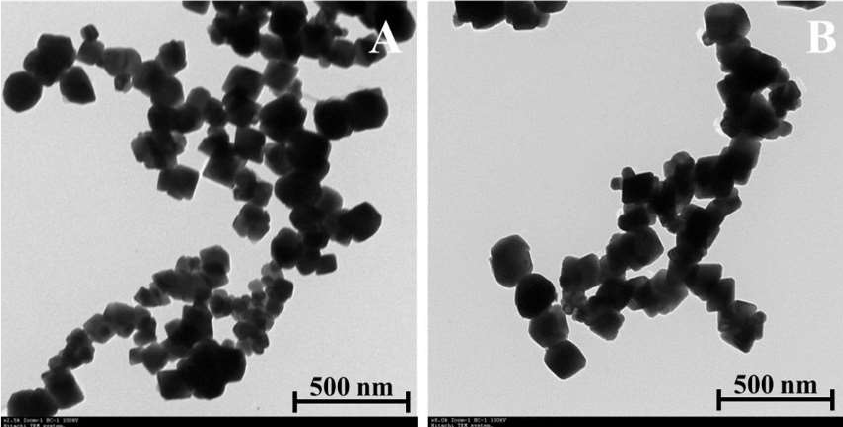
Figure 4. Representative TEM images (8000× magnification) of ( A ) SPIONs and ( B ) CG-PEG-CSO-SPIONs.